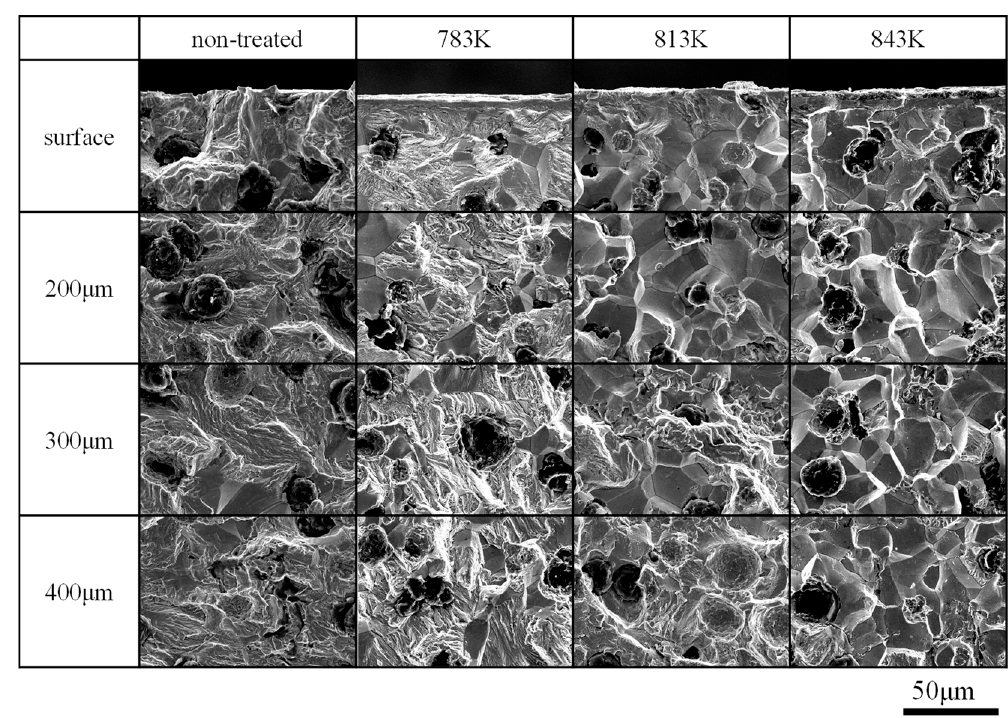
Figure 11. SE images of fracture surface of ASPN-treated samples.